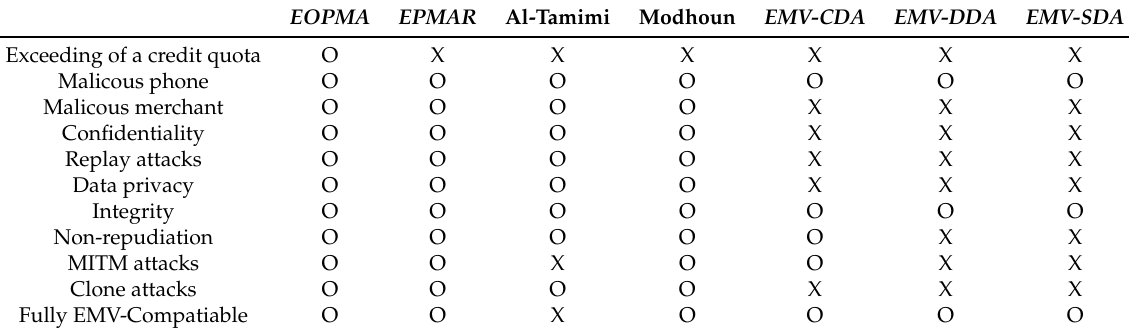
Table 2. Security comparison chart.